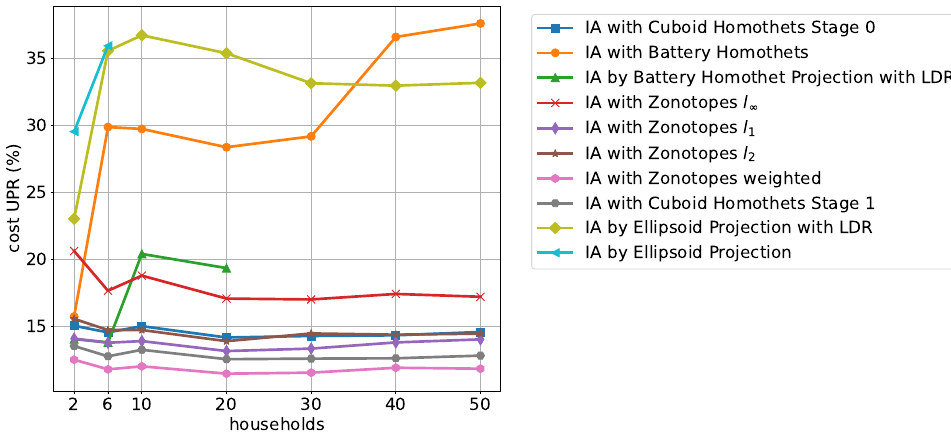
Figure 11. Cost UPR dependence on number of households for 12 time